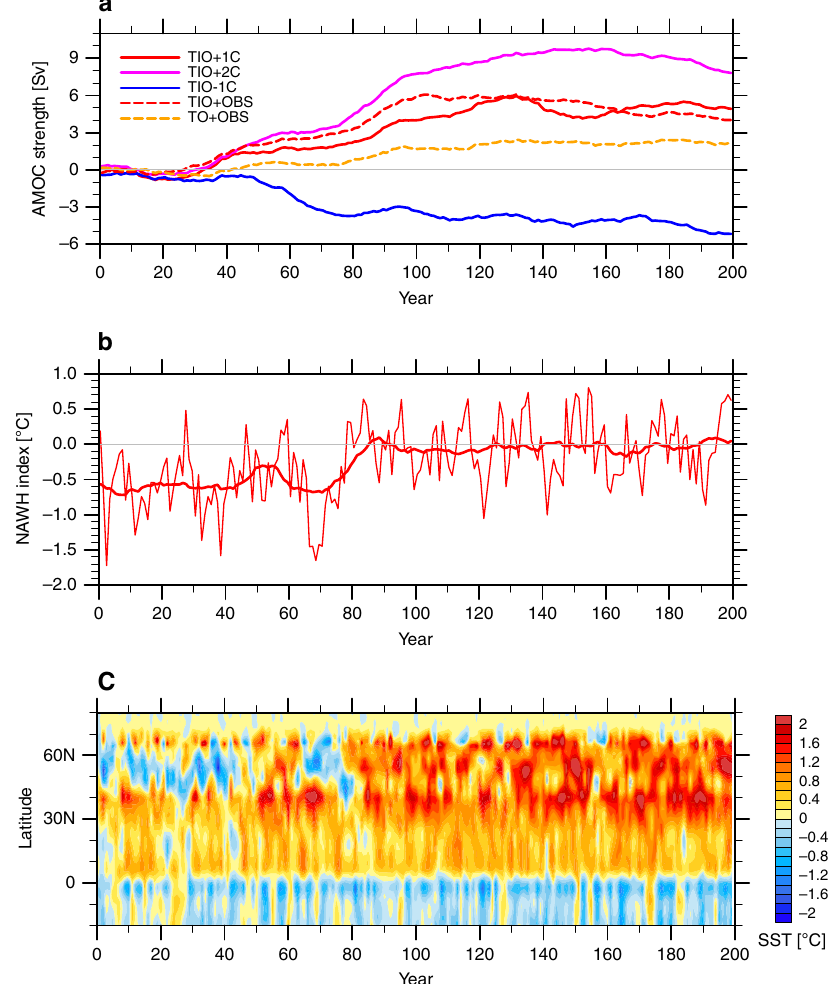
Fig. 7 Atlantic Ocean response to tropical Indian Ocean (TIO) warming. a Variations in annual-mean Atlantic meridional overturning circulation (AMOC) strength in different sensitivity experiments. The AMOC strength is estimated as the maximum streamfunction within 500 – 5500 m, 28° N to 90° N. A 21- year running mean is applied. b Variations in annual-mean anomalous North Atlantic warming hole (NAWH) index in TIO + 1C; the thick curve represents the 21-year running mean. The NAWH index is de fi ned as the SST difference between the subpolar North Atlantic (45°N – 65°N, 50°W – 20°W) and the basinwide extratropical North Atlantic (30°N – 65°N, 70°W – 10°W), see Fig. 1a. c A Hovmoller diagram of annual-mean zonal-mean SST anomaly (°C) averaged within 60°W-0° in TIO +